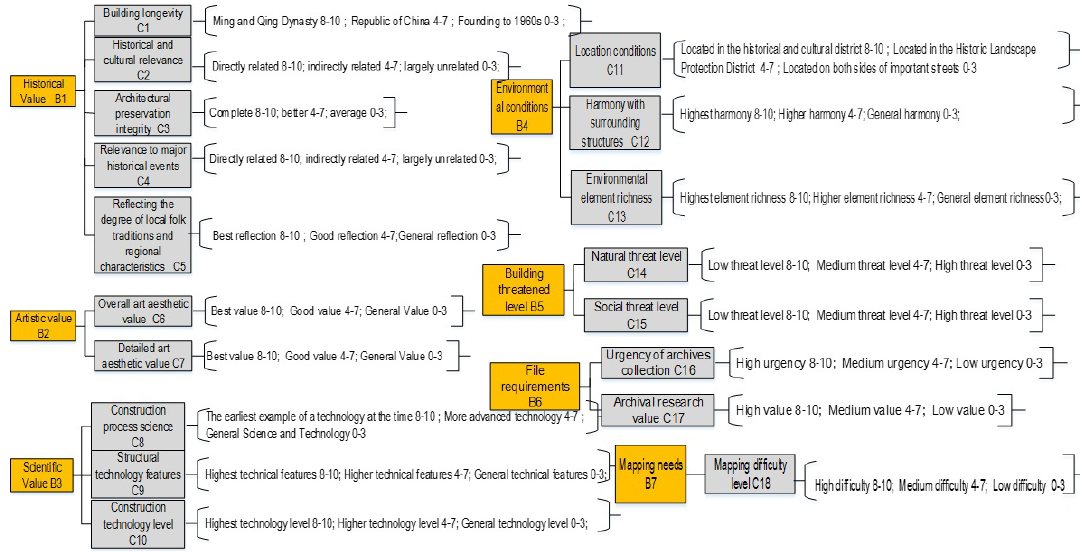
Fig. 4 Index system of historical building value evaluation